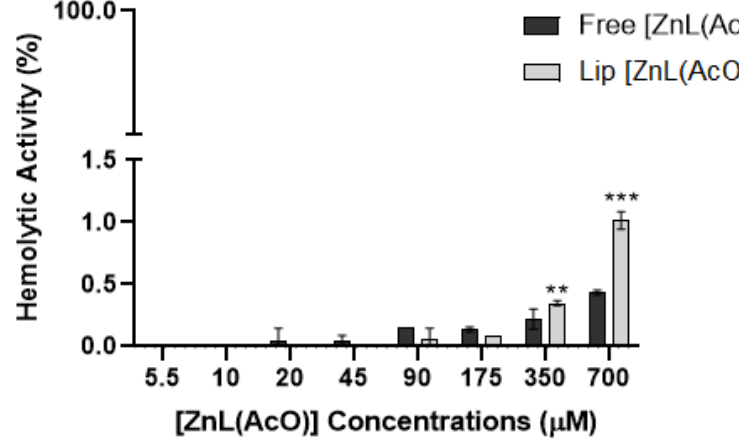
Figure 6. Hemolytic activity of [ZnL(AcO)] in free and liposomal forms in human RBCs. Tested [ZnL(AcO)] concentrations ranged from 5.5 to 700 µM. Data are expressed as means ± standard deviations of two independent experiments (** p < 0.01 vs. free [ZnL(AcO)], *** p < 0.001 vs. free [ZnL(AcO)]).